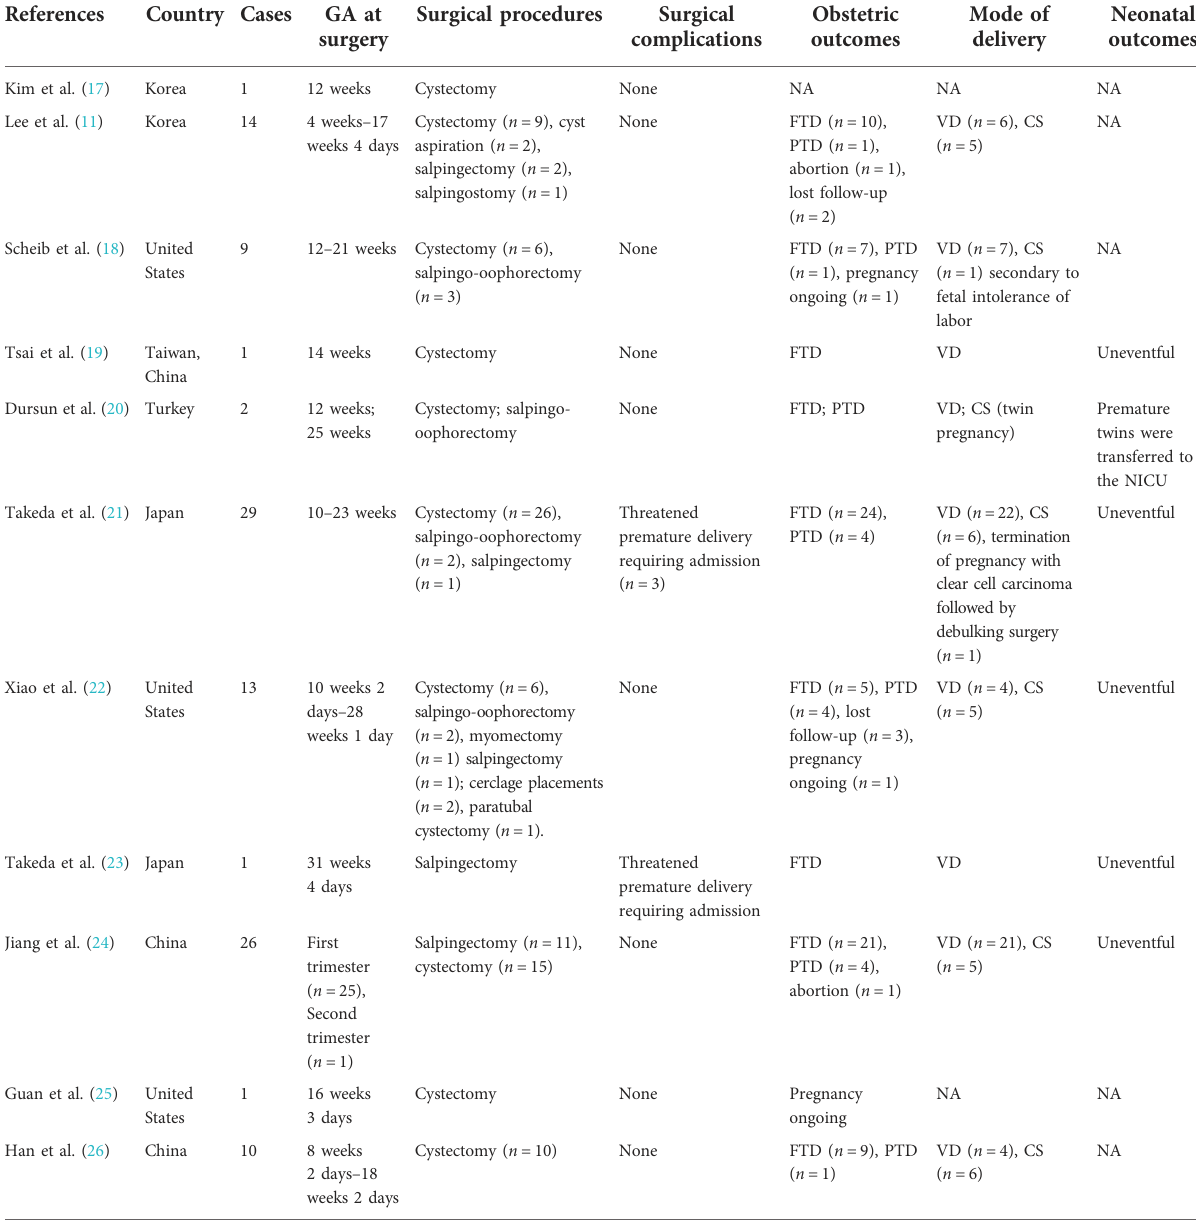
TABLE 3 Published literature studies on LESS for gynecologic disease during